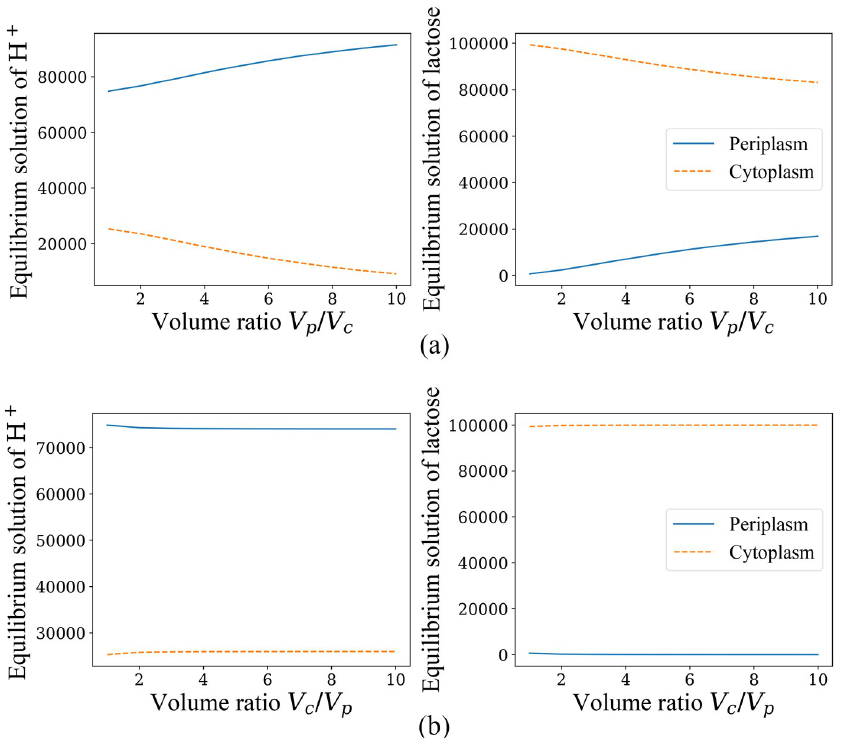
Fig 4. The equilibium solutions for ξ = 0 when V or V is fixed and the other one varies. (a) The equilibium c p solutions of H + and lactose when V is fixed to 10 6 / C 0 and V / V > 1, with initial conditions n c p c ¼ 10 5 , N L ¼ 2 : 5 � 10 4 , N L ¼ 7 : 5 � 10 4 ; N H þ ¼ 10 3 . (b) The equilibium solutions of H + and lactose when V N H þ p c p c / V < 1, with the same initial conditions before. fixed to 10 6 / C 0 and V p c https://doi.org/10.1371/journal.pone.0263286.g004 concentration of particles in periplasm and cytoplasm in initial conditions should be fixed, so that the results are more realistic. The following Fig 5(a) and 5(b) are plotted with V horizontal coordinate (with V fixed) and V / V as the horizontal coordinate (with V c c p respectively, and the time to reach the equilibrium solution as the vertical coordinate.